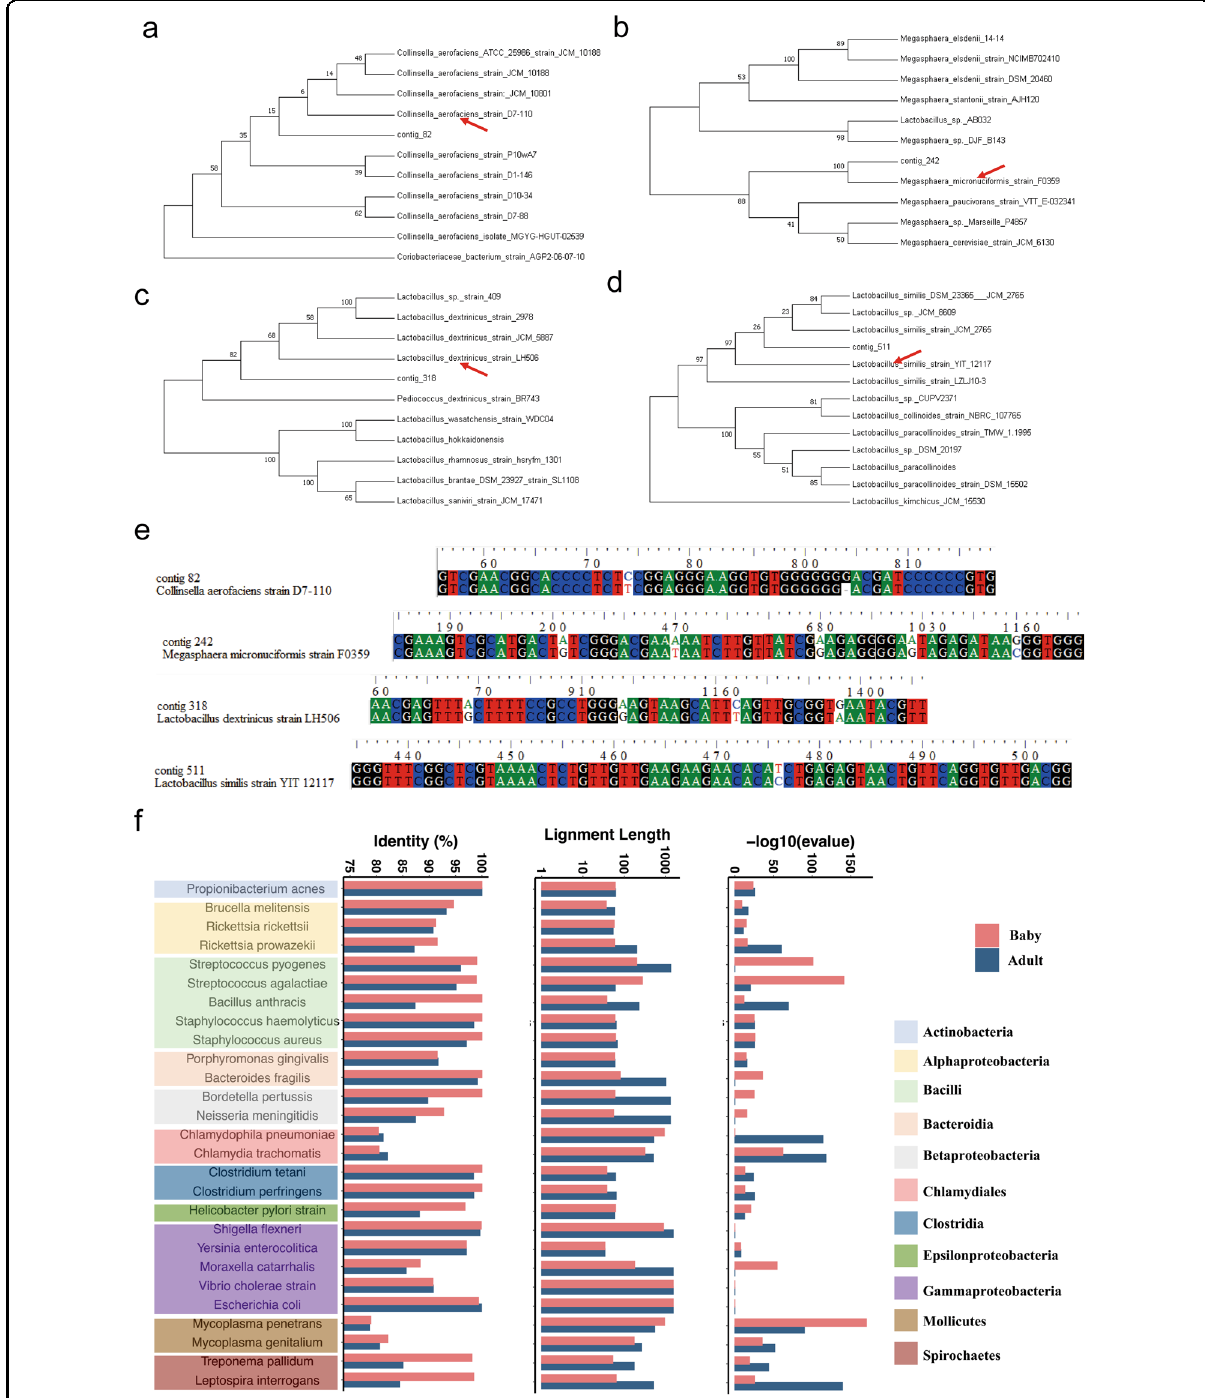
Fig. 4 Phylogeny of four high identity non-match genomes. a – d Phylogenetic tree of the high identity non-match genomes through full-length 16s rRNAs, showing their accurate taxonomic location. e ClustalW multiple alignment of the full-length 16s rRNAs of these genomes with that of the related bacterial strains. f Conditional pathogens Shigella fl exneri lived in the gut of adult and